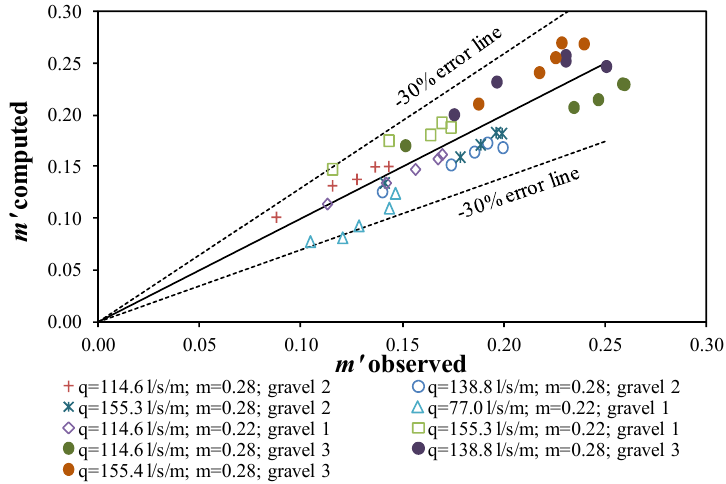
Figure 16. Comparison of observed void ratio with the value computed with Equation (7).